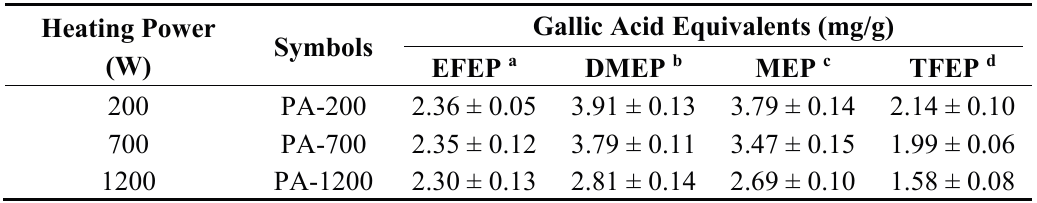
Table 4. Total phenolic content of PA